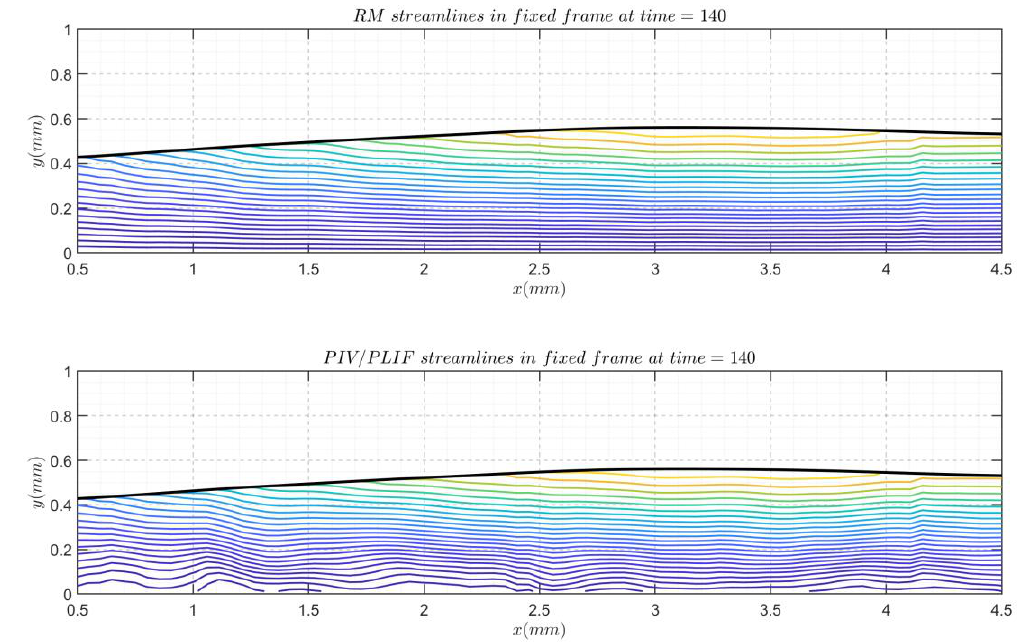
Figure 12. Comparison between the experimental instantaneous velocity profiles and the corresponding model-reconstructed velocity profiles for the Re = 7.43, f = 5 Hz glycerol film flow case.